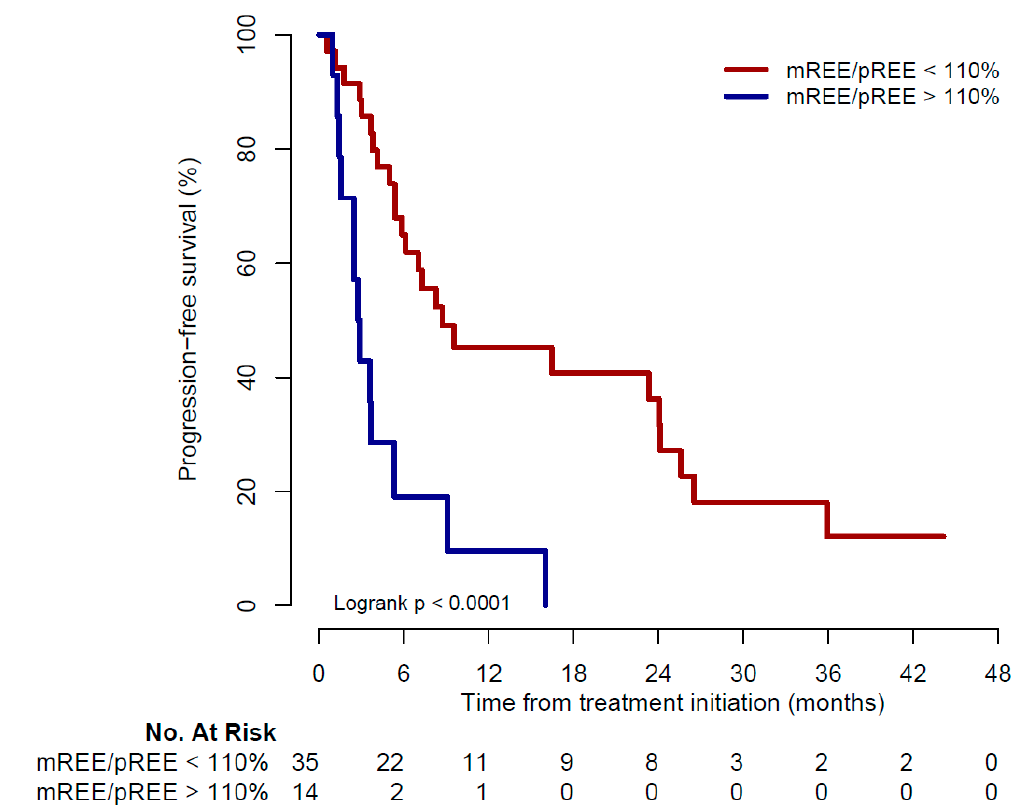
Figure 2. Kaplan–Meier curve for progression-free survival. mREE: measured resting energy expen- diture; pREE: predicted resting energy expenditure.